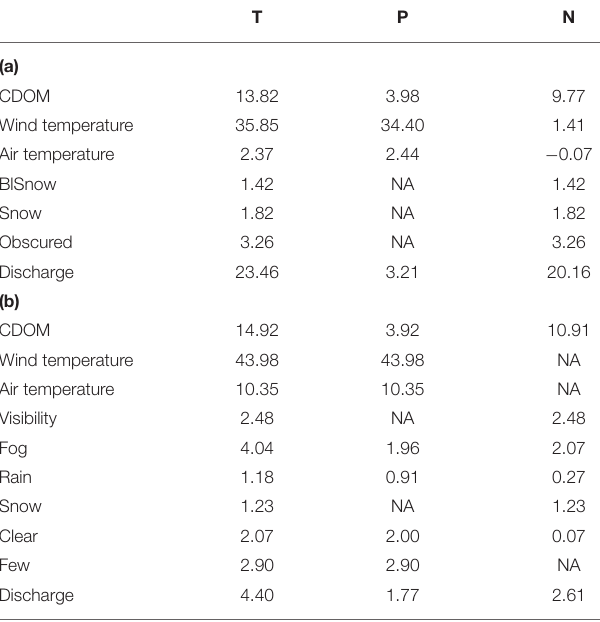
TABLE 2 | Table of adjusted coefficients of multiple determination ( R 2 adj ) associated with the constructed dbMEM variables depending on the explanatory variable with which they showed the highest absolute codependence coefficient for hourly data of chlorophyll a (a) and phycocyanin (b).